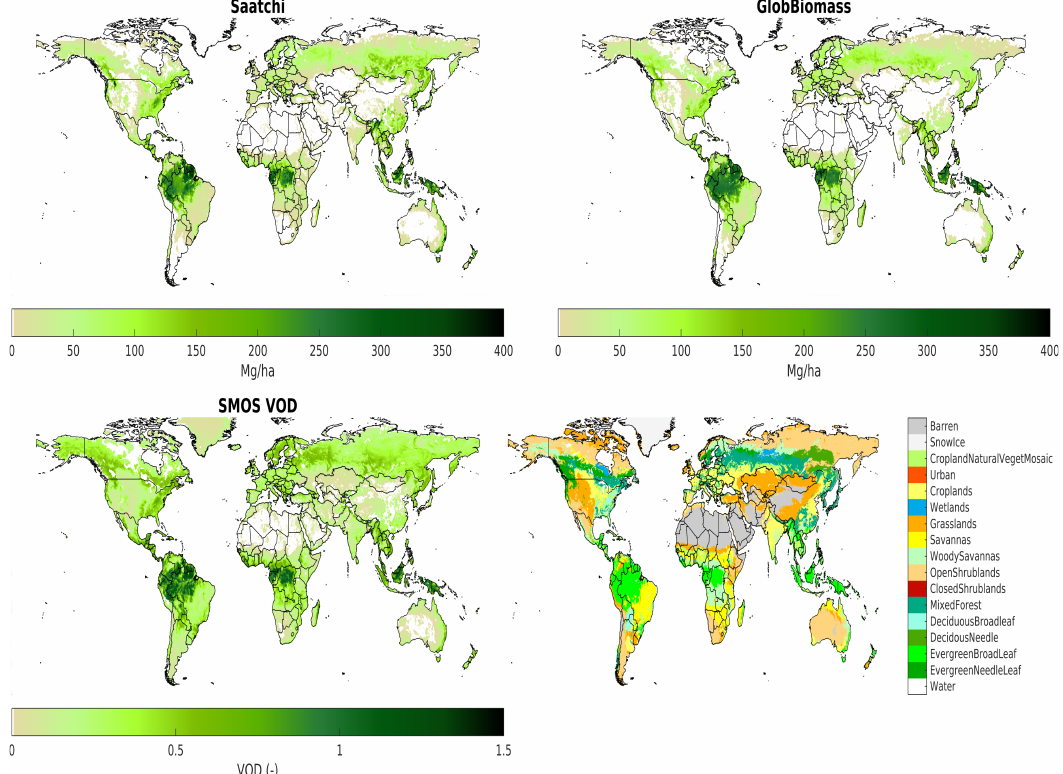
Figure 1. Above ground biomass (AGB) global maps (Saatchi top left , GlobBiomass top right ) and Soil Moisture and Ocean Salinity (SMOS) derived L band Vegetation Optical Depth (L-VOD) map for 2015 ( bottom left ). Bottom right panel shows the International Geosphere-Biosphere Program (IGBP) land surface